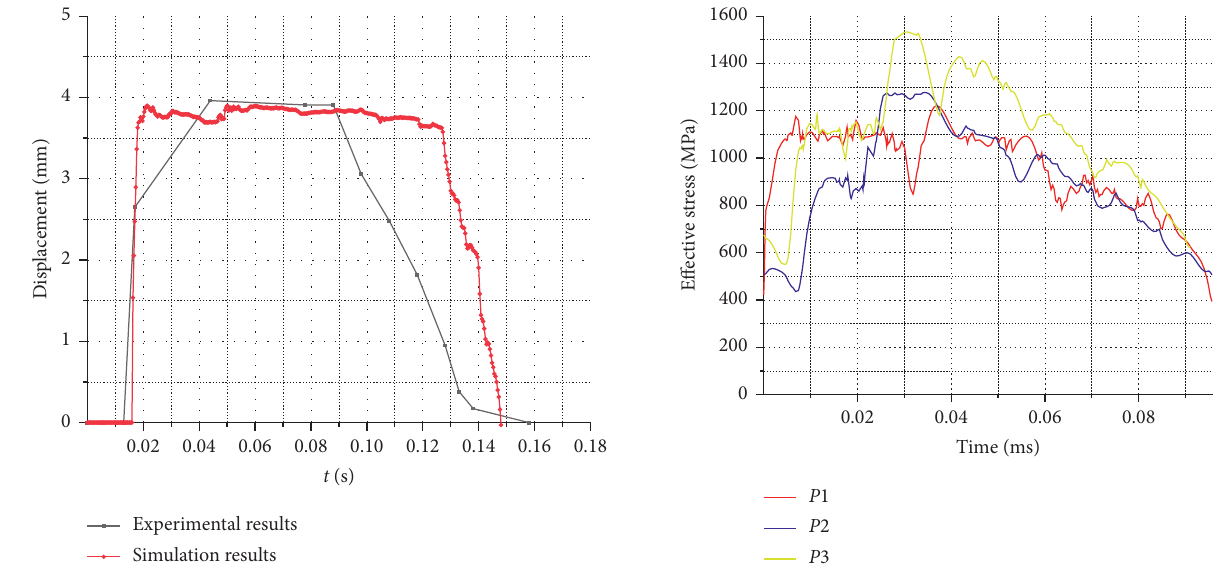
Figure 22: The stress-time history curve of the three dangerous